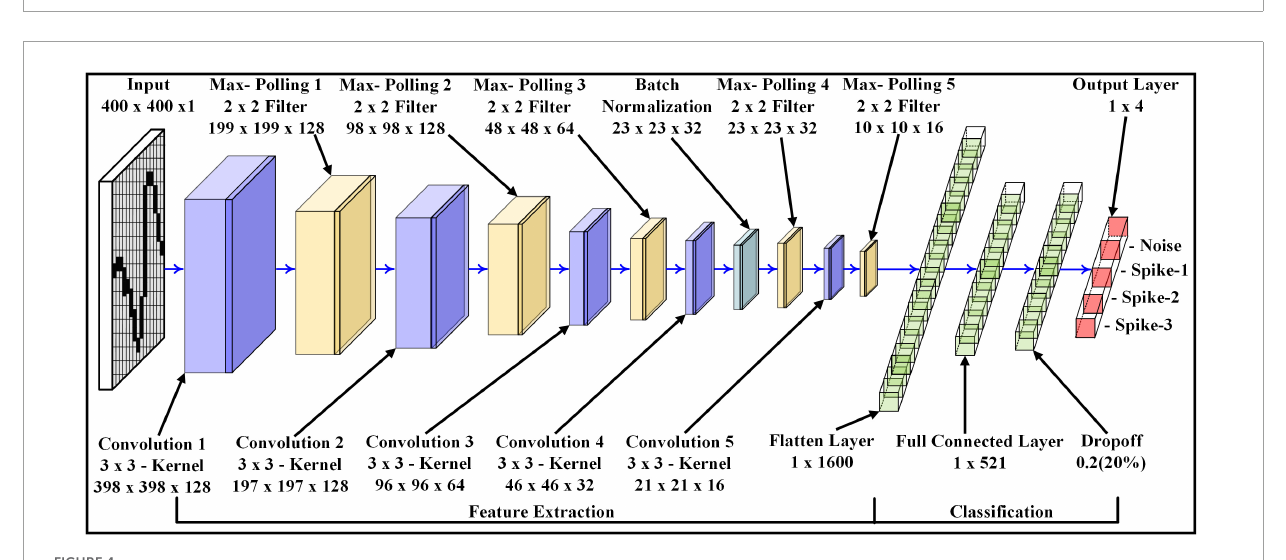
FIGURE4 Modified 2D CNN architecture for feature extraction and classification of four classes.